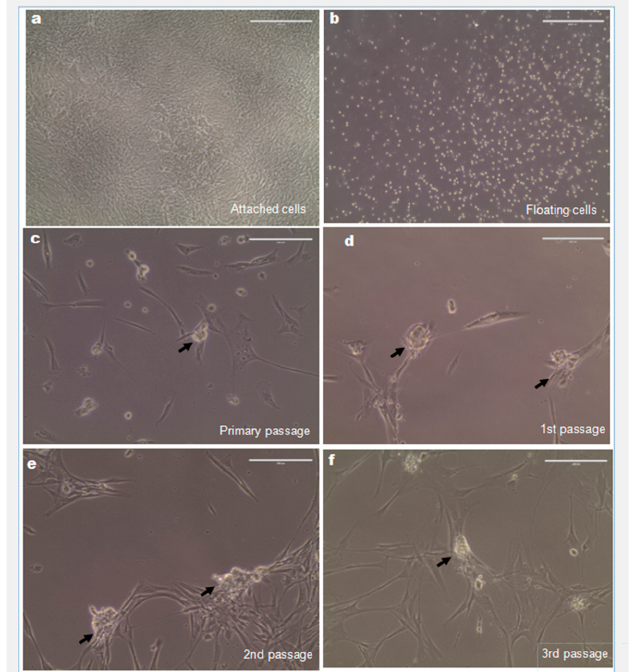
Figure 2. Spermatogonial stem cell (SSC)-like cell clusters were continuously formed in vitro. ( a ) The attached cell from the first plate formed confluence after 12 days. ( b ) SSC-enriched fractions (floating cell in first plates) was subsequently cultured in the StemPro-34 stem cell xeno-free media. ( c–f ) SSC-like cell clusters were formed in primary, first, second and third passages derived from SSC-enriched fractions cultured in xeno-free media. Arrows show the SSC-like cell clusters. Scale bars: 200 µm.